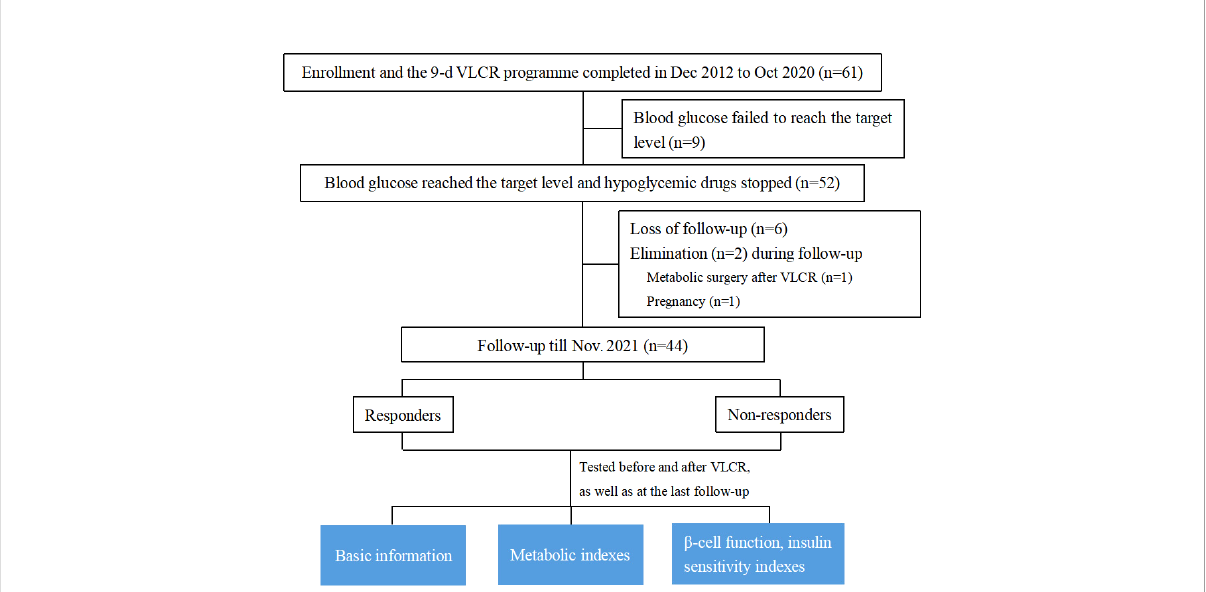
FIGURE 1 Study fl ow chart: Enrollment, drop-out and retention. VLCR, very low-calorie restriction; Wc, waist circumstance; WHR, waist-hip-rate; AIR, acute insulin response; IAUC in IVGTT, insulin area under curve in intravenous glucose tolerance test; IAUC in OGTT, insulin area under curve in oral glucose tolerance